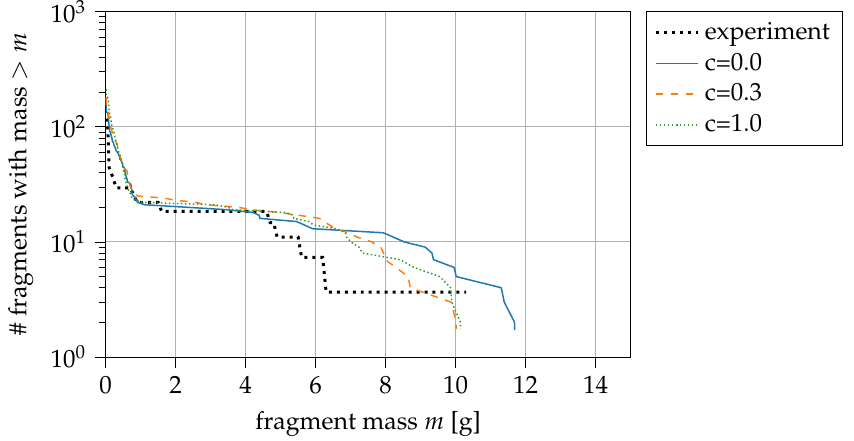
Figure 8. Coupling of plasticity and fracture model: c = 0 is no coupling, c = 0.3 is best fit, and c = 1.0 is the description in classical damage mechanics; experiment from